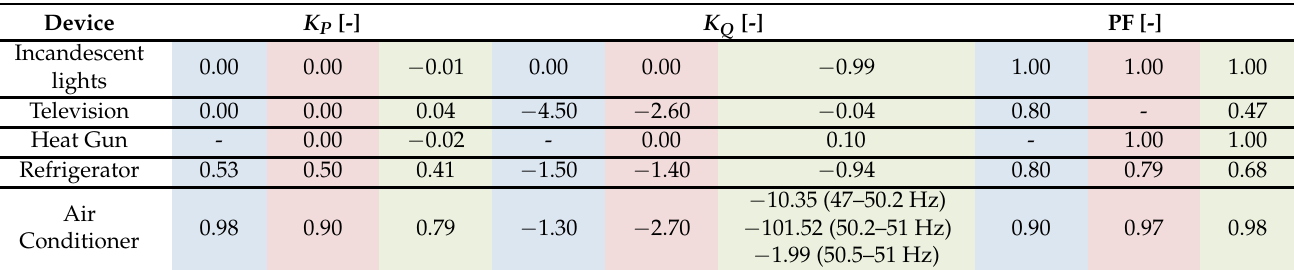
Table 7. Comparison of the frequency sensitivity coefficient based on 3 different literature